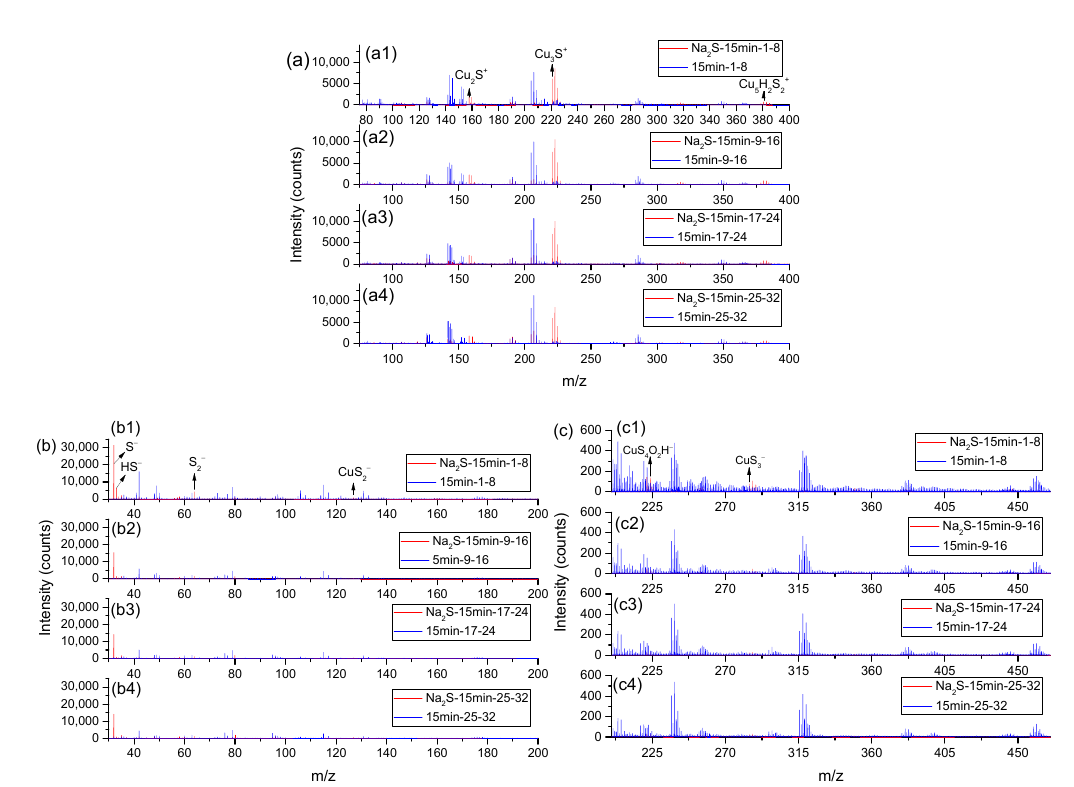
Figure 2. Cumulative mass spectra at different depths at pH 9: ( a ) positive spectrum; (a1–a4) are cumulative positive spectra obtained from scans 1–8, 9–16, 17–24, and 25–32, respectively; ( b ) and ( c ) negative spectra; (b1) (c1), (b2) (c2), (b3) (c3), and (b4) (c4) are cumulative negative spectra obtained from scans 1–8, 9–16, 17–24, and 25–32, respectively. Red and blue lines represent sulfidized and unsulfidized malachite, respectively.